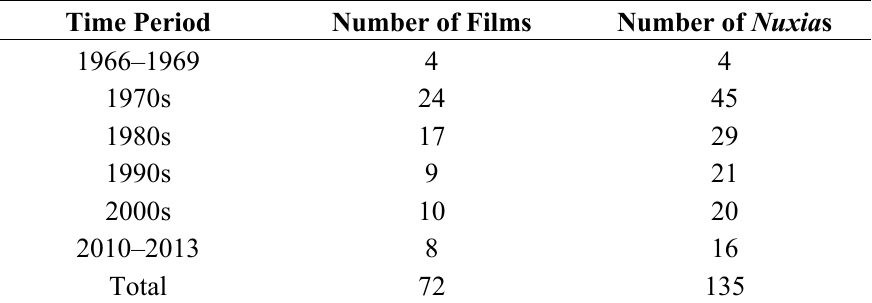
Table 1. Numbers of films and nuxia characters in different